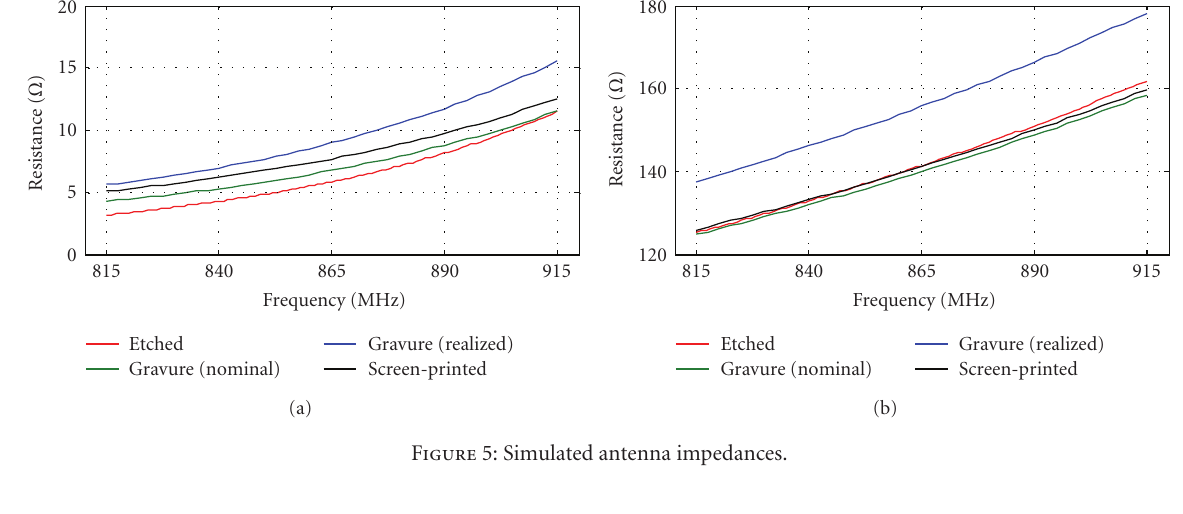
Figure 5: Simulated antenna impedances.